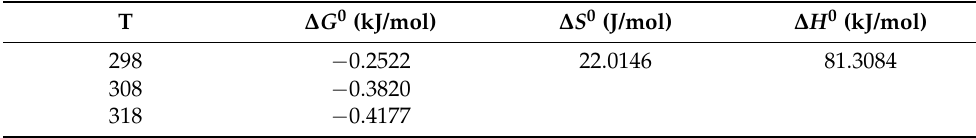
Figure 8. Thermodynamic fitting curve of adsorption of Cr(VI) on Mxene–CS. Table 3. Thermodynamic parameter values for Cr(VI) adsorption.